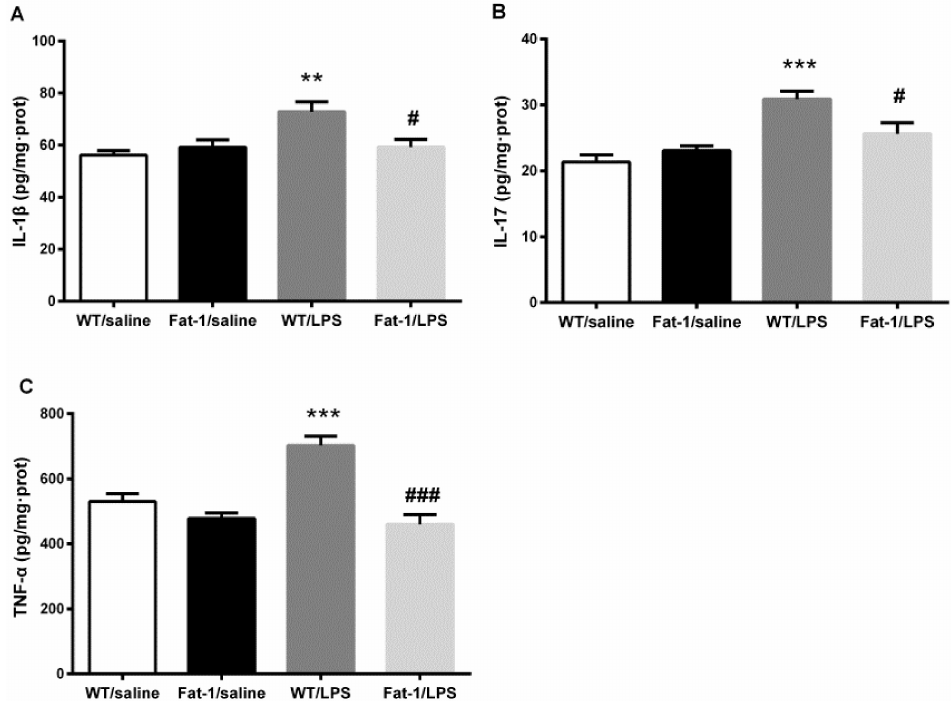
Figure 5. LPS up-regulated interleukin (IL)-1 β , IL-17, and tumor necrosis factor (TNF)- α concentration significantly in WT littermates. These changes were markedly attenuated in Fat-1 mice. ( A ) IL-1 β ; ( B ) IL-17; ( C ) TNF- α . ** p < 0.01, *** p < 0.001vs. WT/saline; # p < 0.05, ### p < 0.001 vs. WT/LPS. LPS: lipopolysaccharides; WT: Wild-type.